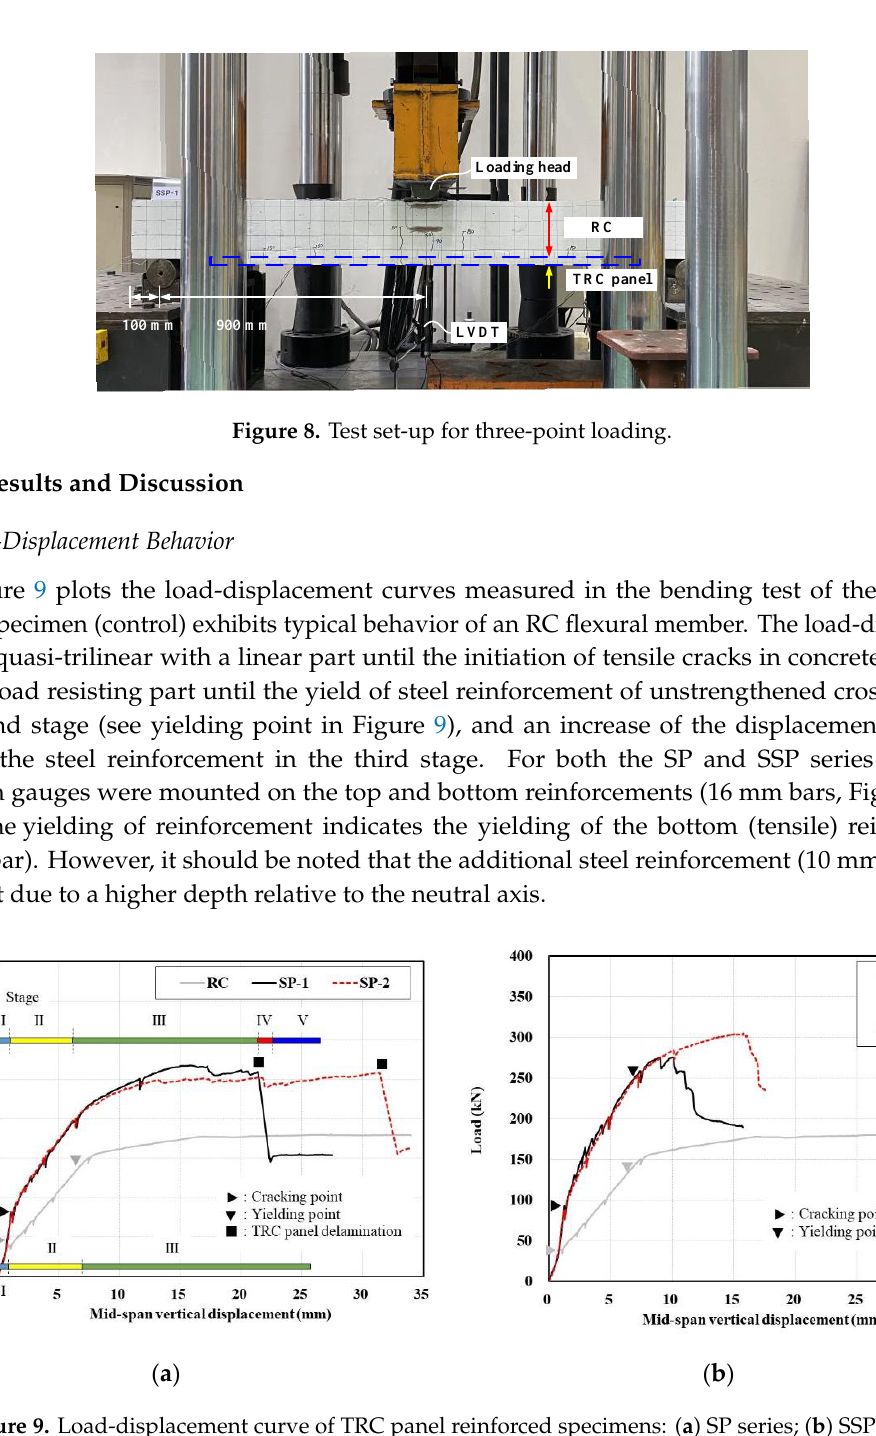
( d ) Figure 7. Fabrication of SP and SSP series specimens: ( a ) concrete surface chipping; ( b ) TRC panel assembling; ( c ) grouting pumping; ( d ) grouting. 2.4. Test-Set Up